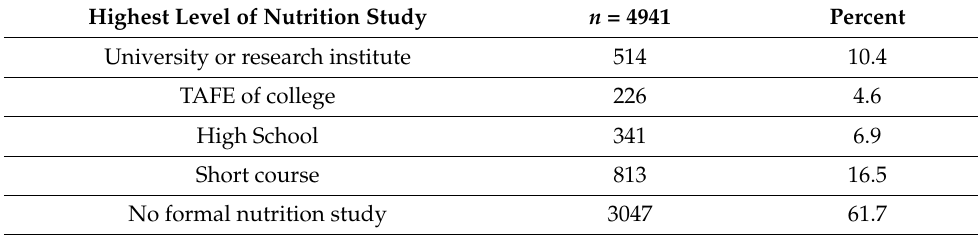
Table 3. Participant reported highest level of studying nutrition before commencing the MOOC.